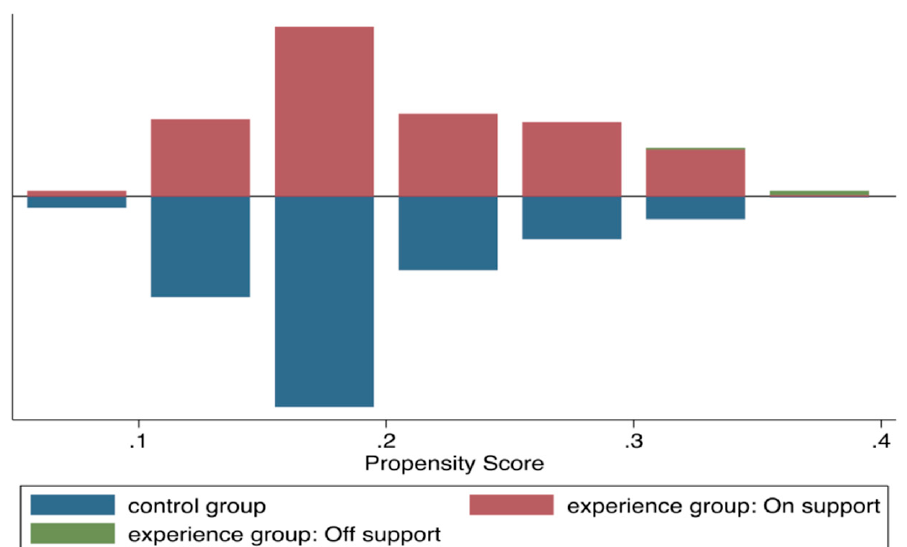
Figure 3. Check common support.